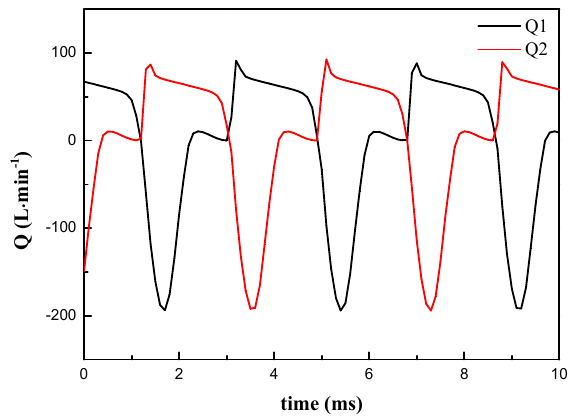
Figure 5. Pressures of hydraulic cylinder’s two chambers.